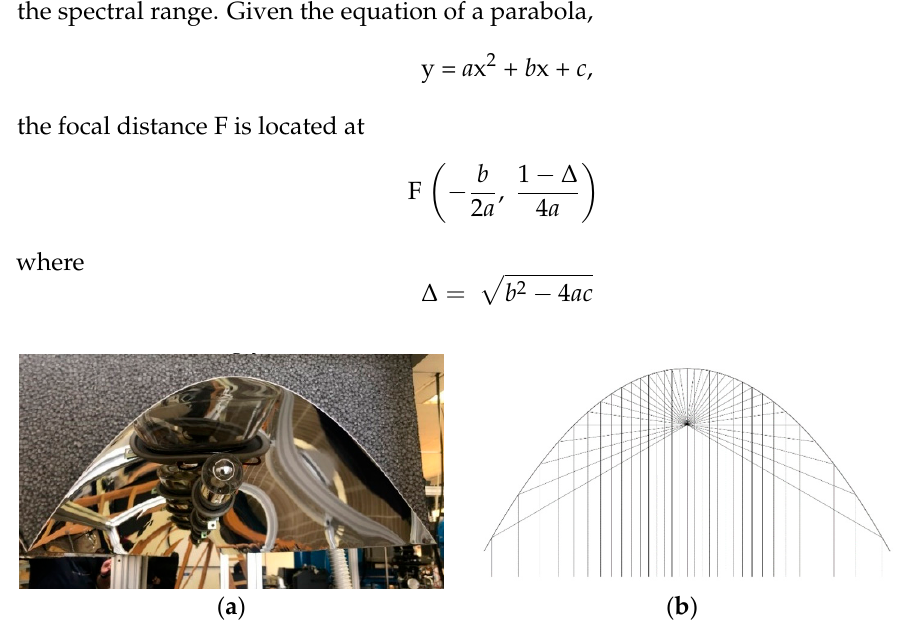
Figure 2. Detail of a lamp mounted under the parabolic mirror ( a ) and the theoretical representation ( b ).